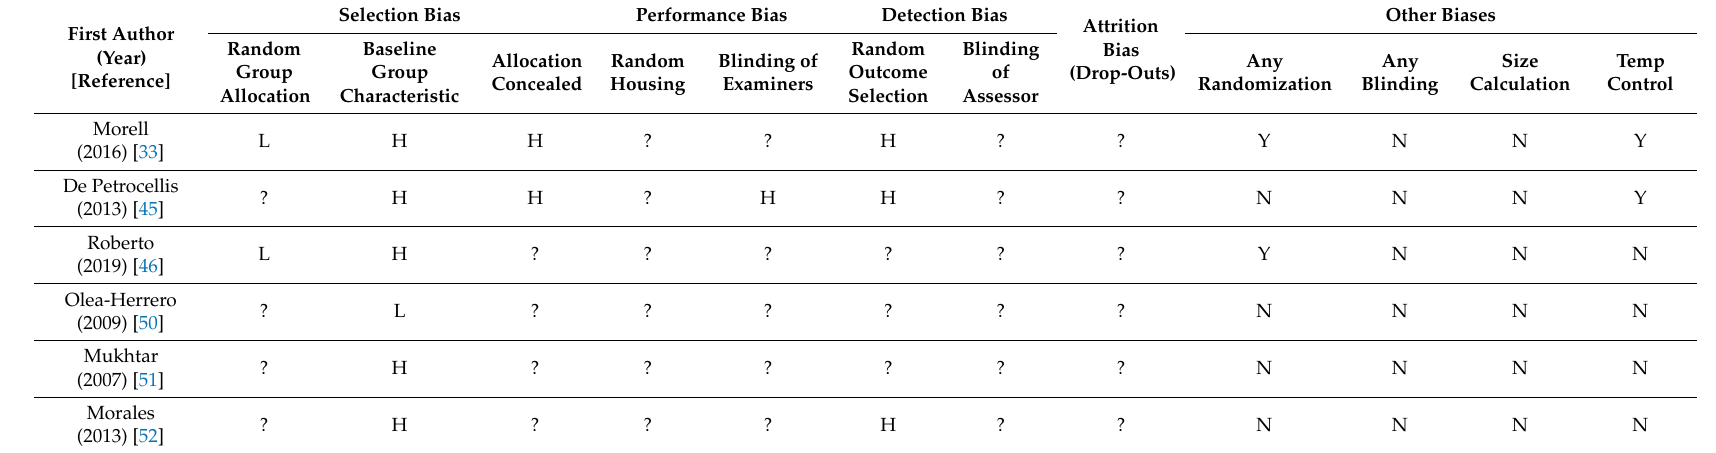
Table 1. Assessment of the risk of bias in animal studies using SYstematic Review Centre for Laboratory animal Experimentation (SYRCLE)